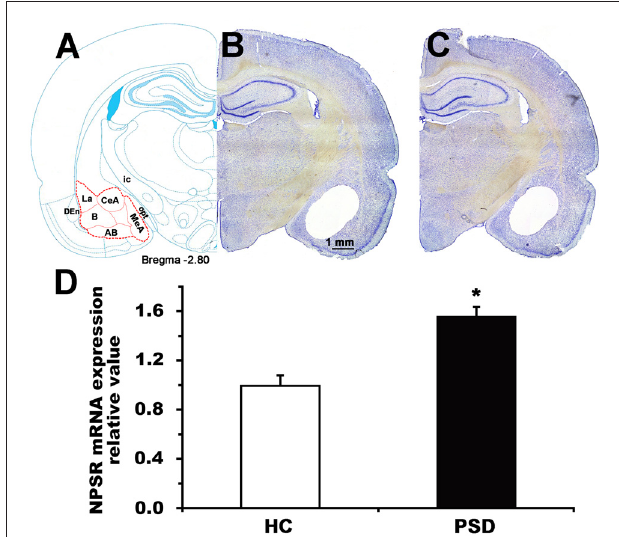
FIGURE 6 | NPSR mRNA expression level of the amygdala in control and 24-h PSD rats. Schematic representation (A) shows the area (red dashed line) sampled for mRNA measurement in the coronal section at − 2.80 mm from bregma (Paxinos and Watson, 1998). Representative photographs (B,C) show blank area from where the samples of amygdala were punched in home cage control (HC) and PSD rats, respectively. Histograms (D) shows presented the relative value of NPSR mRNA expression in HC and PSD rats. Values are means ± SEM ( n = 5 per group). ∗ P < 0.01. Data were analyzed by Student’s t -test. Abbreviations: AB, accessory basal nuclei; B, basal nuclei; CeA, central amygdala; DEn, dorsal endopiriform nuclei; ic, internal capsule; La, lateral nuclei; MeA, medial amygdala; opt, optic tract.